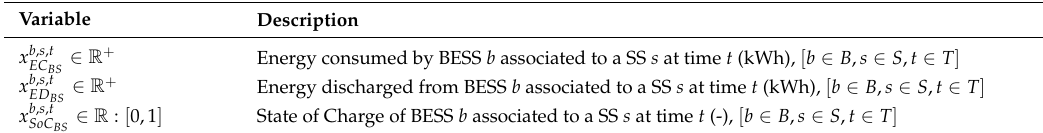
Table 10. Summary of variables (BESS